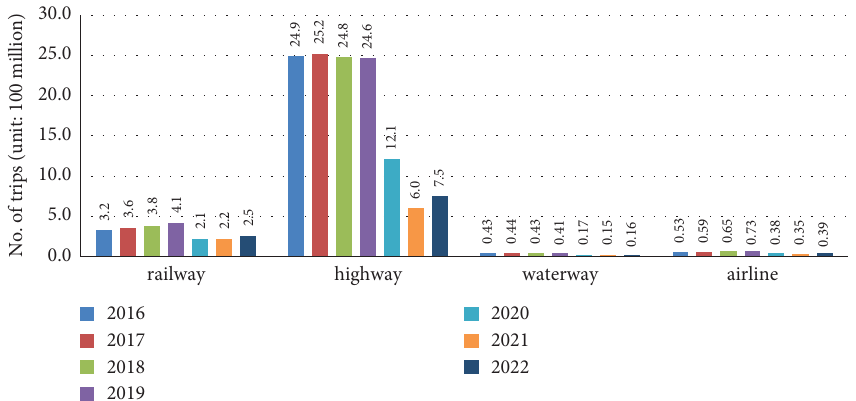
Figure 1: Number of trips in the Spring Festival travel rush for the latest